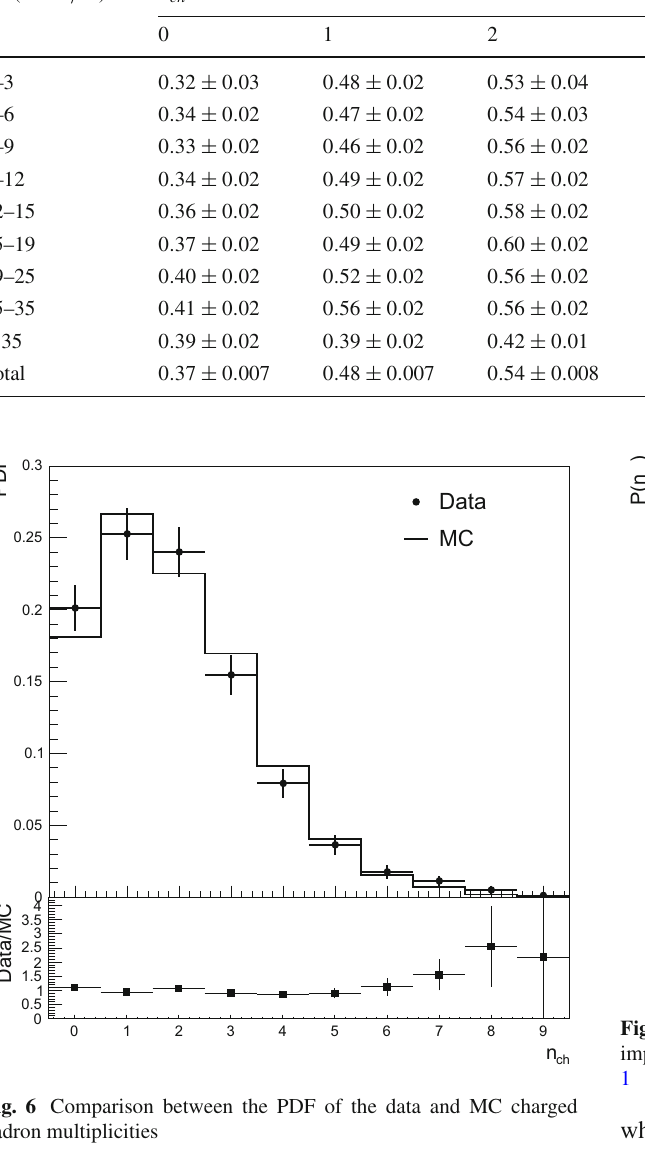
Table 2 Location and reconstruction efficiency as a function of W 2 and the charged hadron n ch multiplicity W 2 ( GeV 2 / c 4 )